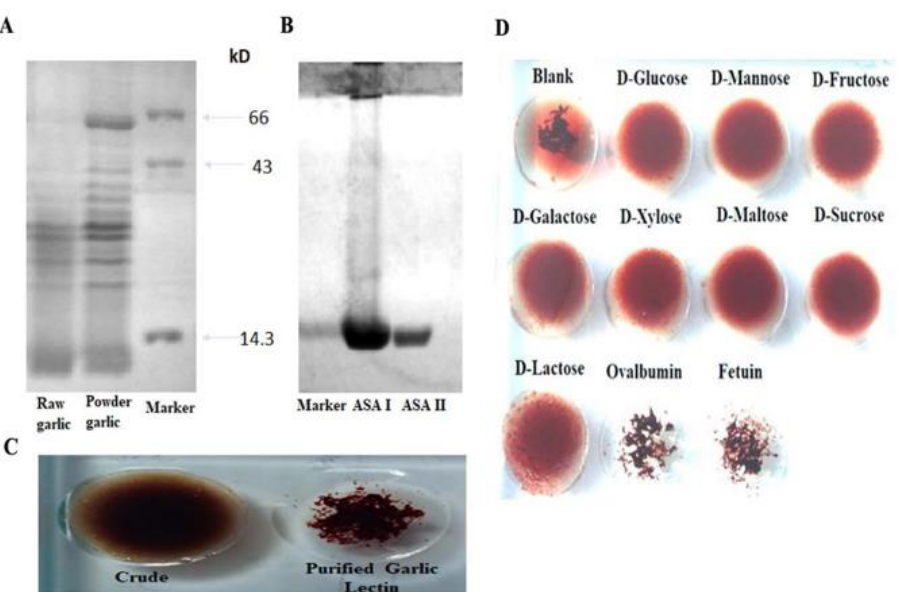
Figure 1. ( A ) SDS-PAGE protein profile of raw garlic and powdered garlic PBS extracts. ( B ) SDS- PAGE of raw garlic, purified lectins (ASA I and II), and molecular mass determination under reducing conditions with Coomassie brilliant blue staining. ( C ) Agglutinating activity with 1% trypsinized rabbit RBCs for the crude extract and purified garlic lectins. ( D ) Agglutination inhibition by mannose, glucose, and maltose, indicating the lectins ’ sugar specificity.